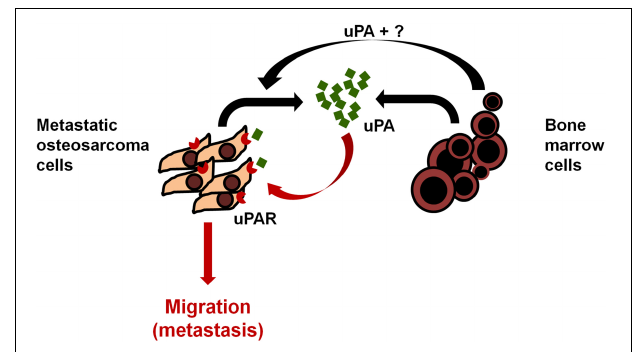
FIGURE 3 | Model of uPA/uPAR signaling in osteosarcoma and the bone microenvironment. Osteosarcoma cells secrete uPA into the surrounding microenvironment which acts in an autocrine fashion by binding to osteosarcoma uPAR and promoting osteosarcoma cell migration, invasion and metastasis. Bone marrow cells in the surrounding microenvironment promote the expression of uPA/uPAR in osteosarcoma cells in a paracrine manner to increase metastasis. Reprinted from Endo-Munoz et al.